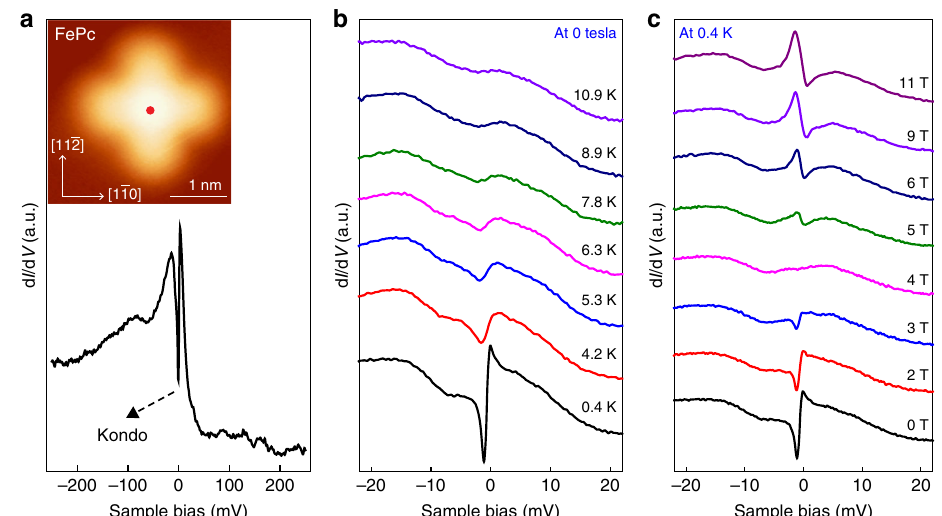
Fig. 2 d I /d V spectra under variation of temperature and magnetic fi eld. a d I /d V spectra taken on the Fe center at 0.4 K and zero magnetic fi eld, showing a Kondo dip superimposed on a broad feature near E F (setpoint: I = 0.2 nA, V b = − 0.1 V). Inset: STM image of an FePc on Au(111) (3.2 nm × 3.2 nm, I = 10 pA, V b = − 0.2 V). b Evolution of the d I /d V spectra of FePc at increasing temperatures in the absence of magnetic fi eld (setpoint: I = 0.3 nA, V b = − 60 mV). Successive spectra are offset for clarity. The dip at E F vanishes above 8 K, making two broad resonances visible. The broad two-peak feature was originally attributed to a Kondo feature in ref. 15 . However, in this work we note the similarity between the spectra and the density of states for the underlying gold bulk (Supplementary Fig. 7), suggesting that this is in fact the source of the broader feature. c Evolution of the d I /d V spectra of FePc with increasing magnetic fi eld at 0.4 K (setpoint: I = 0.3 nA, V b = − 60 mV), showing a dip-to-peak transition. a.u., arbitrary